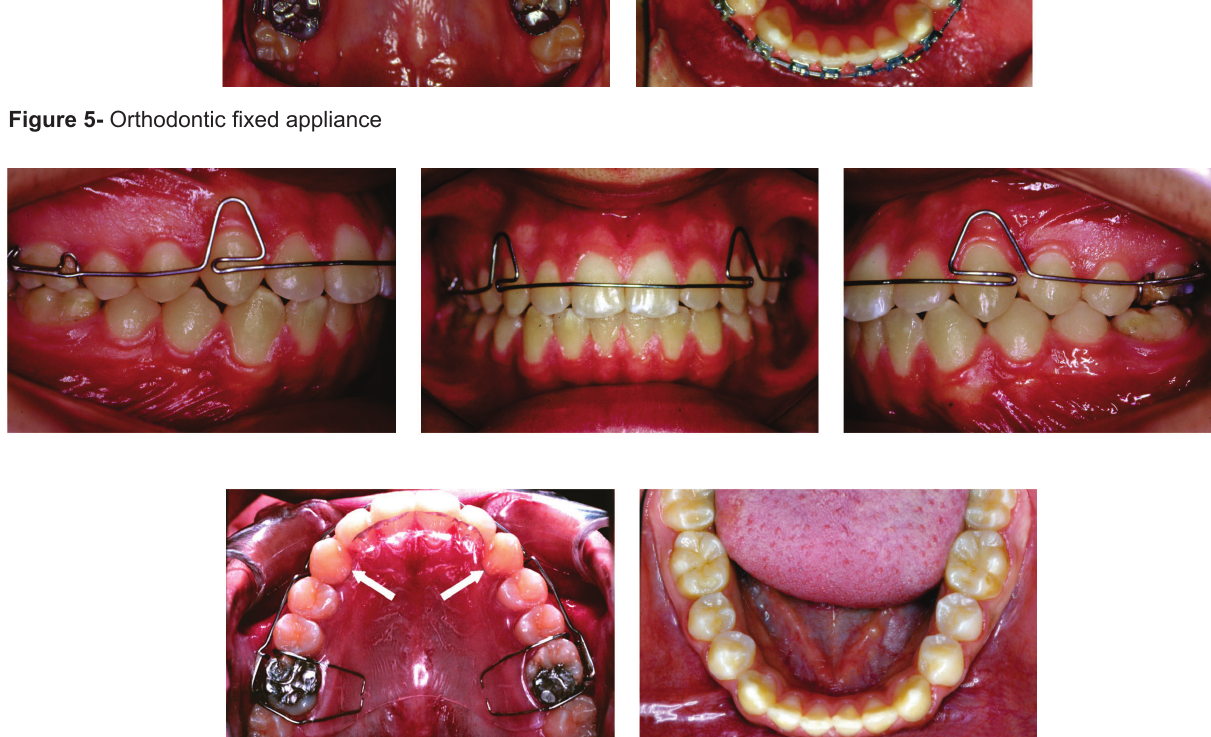
Figure 6- Modified Hawley retainer